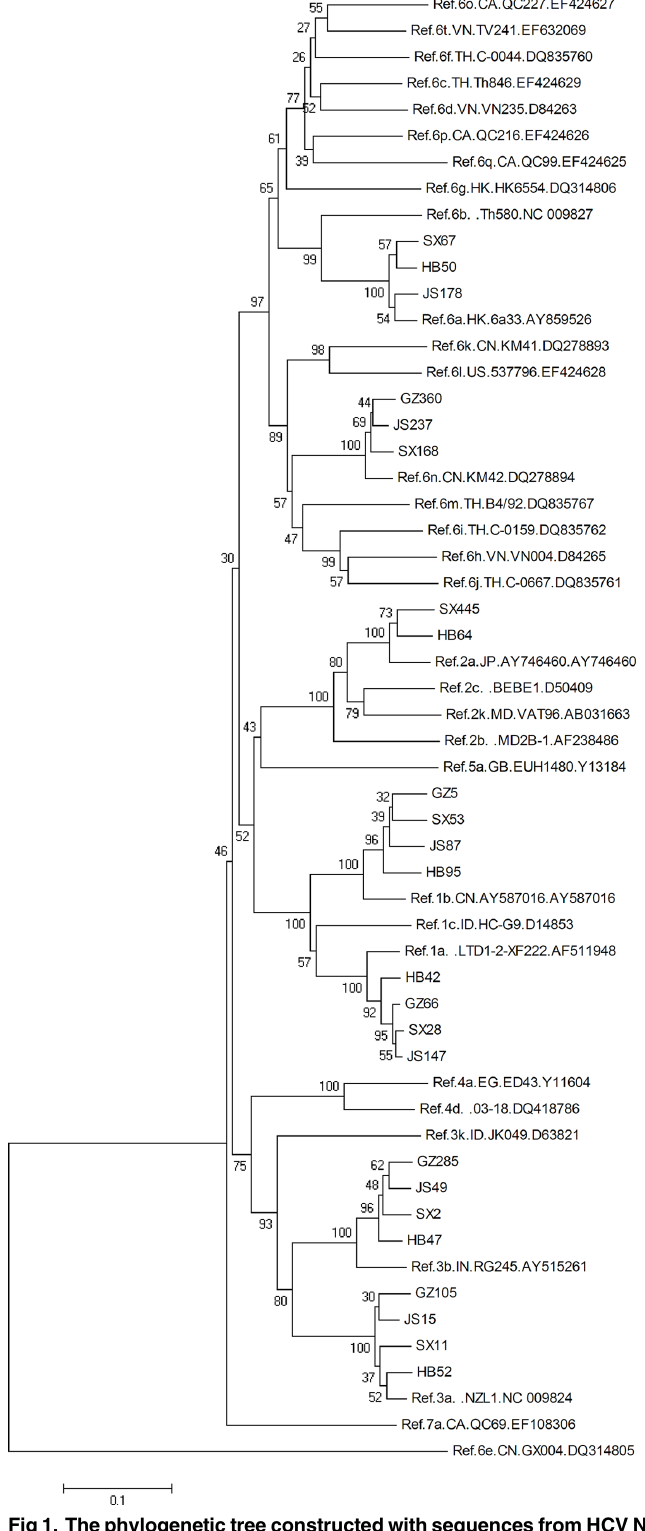
Fig 1. The phylogenetic tree constructed with sequences from HCV NS5B region among Chinese drug users.